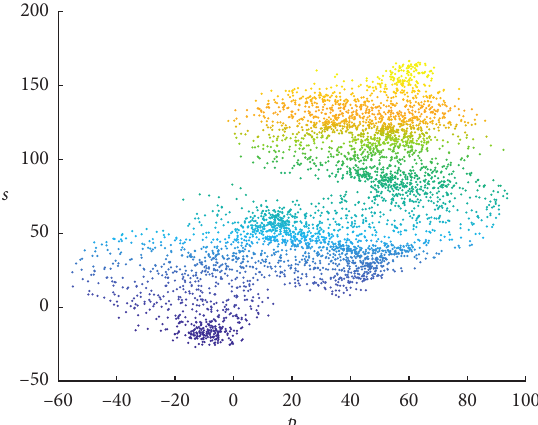
Figure 4: Plots in the new coordinate p-s plane for temperature.